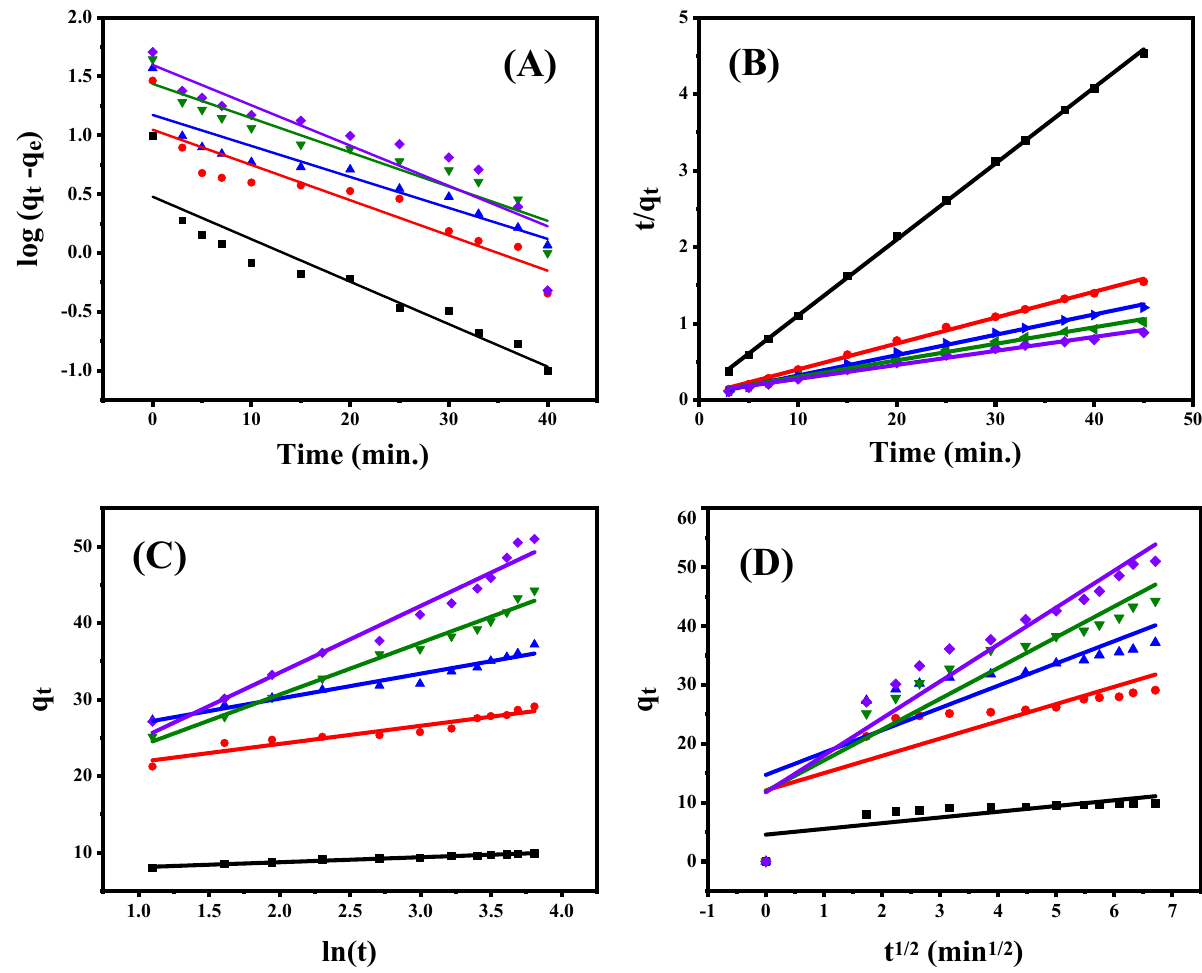
Figure 10. Sorption kinetics of MB dye at 25 °C and pH 7 by 50 mg of adsorbent; ( A ) Pseudo-first order, ( B ) Pseudo-second order, ( C ) Elovich kinetic model and ( D ) Intra-particle